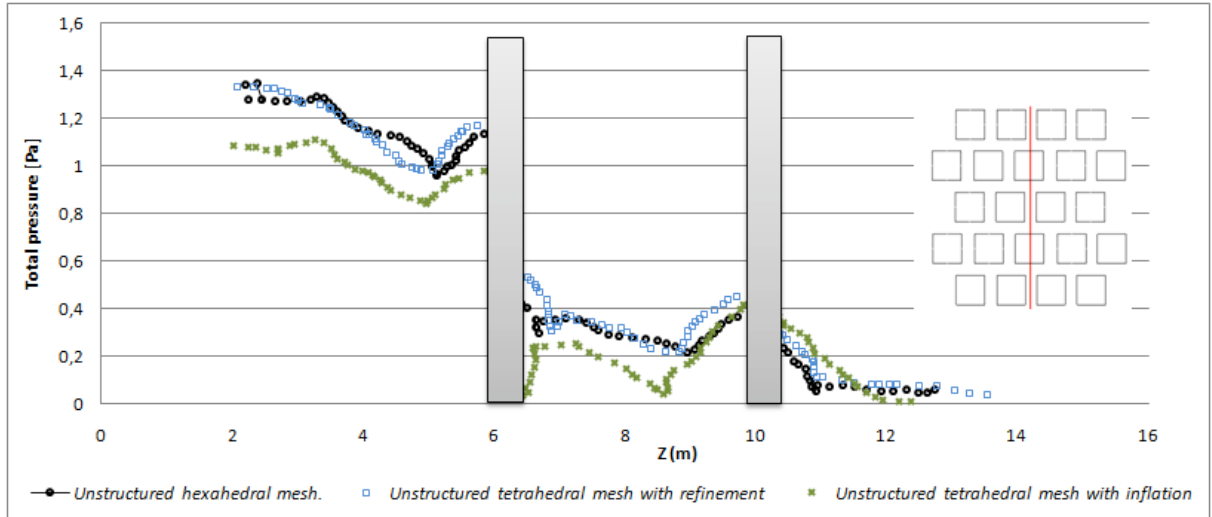
Fig. 6. Total pressure profiles according to type of mesh along Z